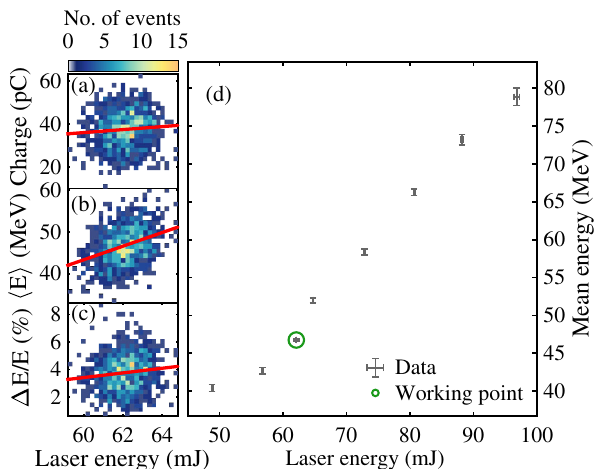
FIG. 4. (a) Correlation plots between on-target ionization-laser energy and charge (a), mean energy (b), and relative energy spread (c) for the injected witness beams in Fig. 3(a). Red lines indicate a linear fit through the data points. (d) Results of a systematic laser-energy scan highlighting the relationship be- tween witness-beam energy and on-target laser energy. Error bars indicate the standard error. The working point for the data presented in this paper is indicated by a green